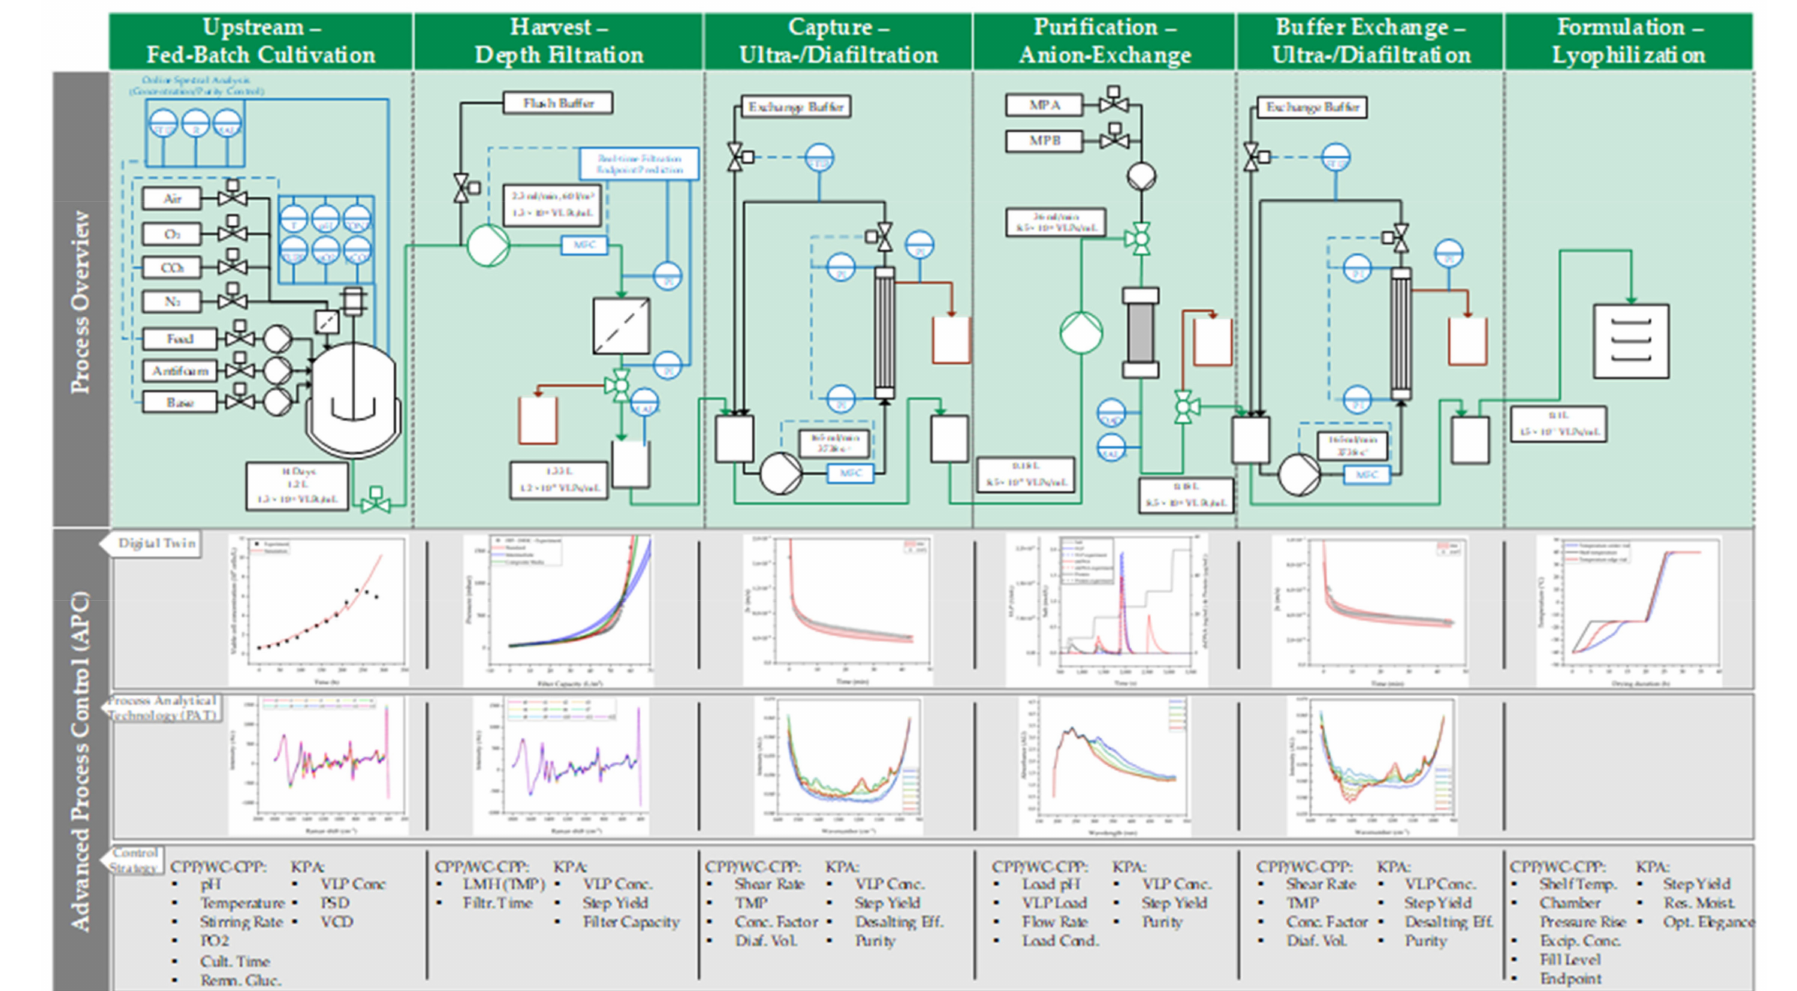
Figure 12. Process flowsheet including APC by digital twins and optimized PAT. Critical Process Parameter (CPP), Well-Controlled Critical Process Parameter (WC-CPP), Key Process Attribute (KPA), particle size distribution (PSD), Viable Cell Density (VCD), transmembrane pressure (TMP), virus-like particle